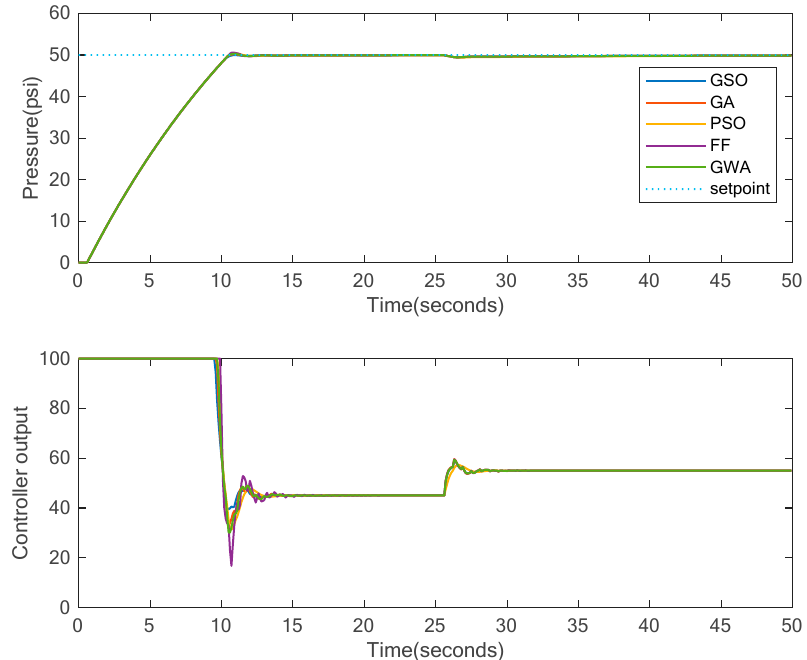
Figure26. Example2: Regulatoryresponseforthepressurecontrolstationwithoptimizationalgorithms. Figure 26. Example 2: Regulatory response for the pressure control station with optimization algorithms.